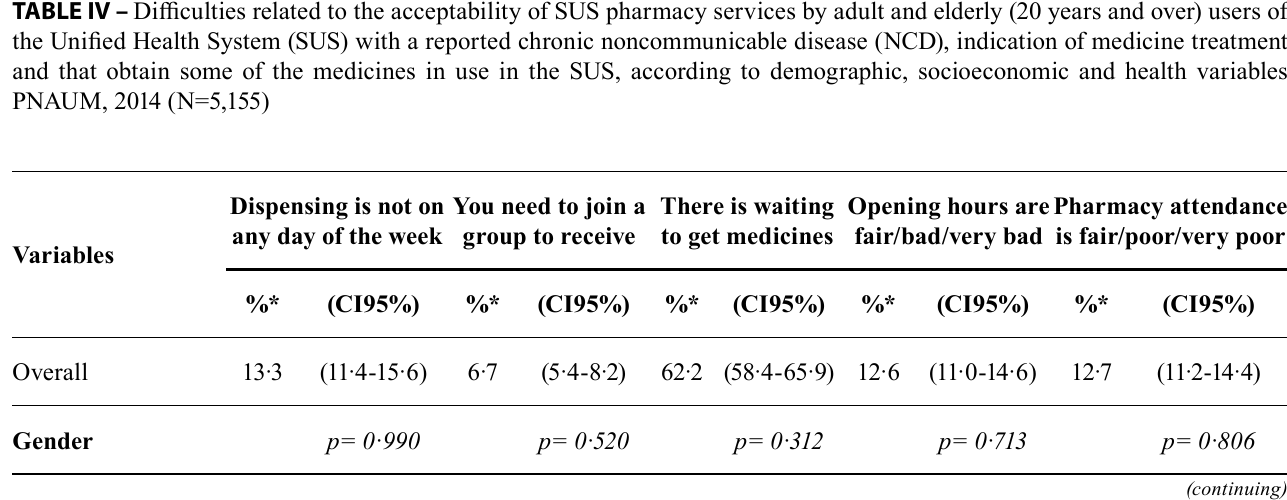
TABLE IV – Difficulties related to the acceptability of SUS pharmacy services by adult and elderly (20 years and over) users of the Unified Health System (SUS) with a reported chronic noncommunicable disease (NCD), indication of medicine treatment and that obtain some of the medicines in use in the SUS, according to demographic, socioeconomic and health